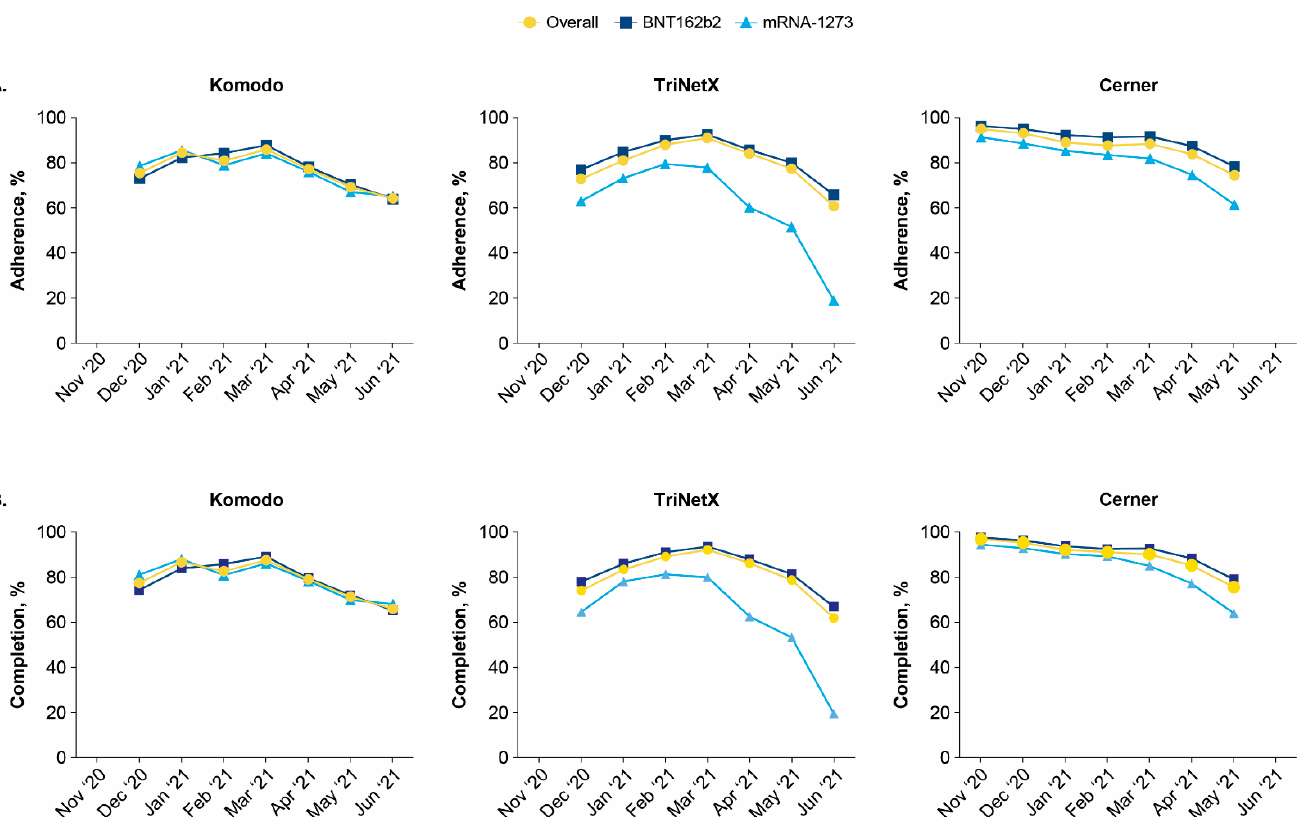
Figure 4. ( A ) Adherence and ( B ) completion by index month in the Komodo, TriNetX, and Cerner databases. Individuals included in Komodo and TriNetX databases were identified from December